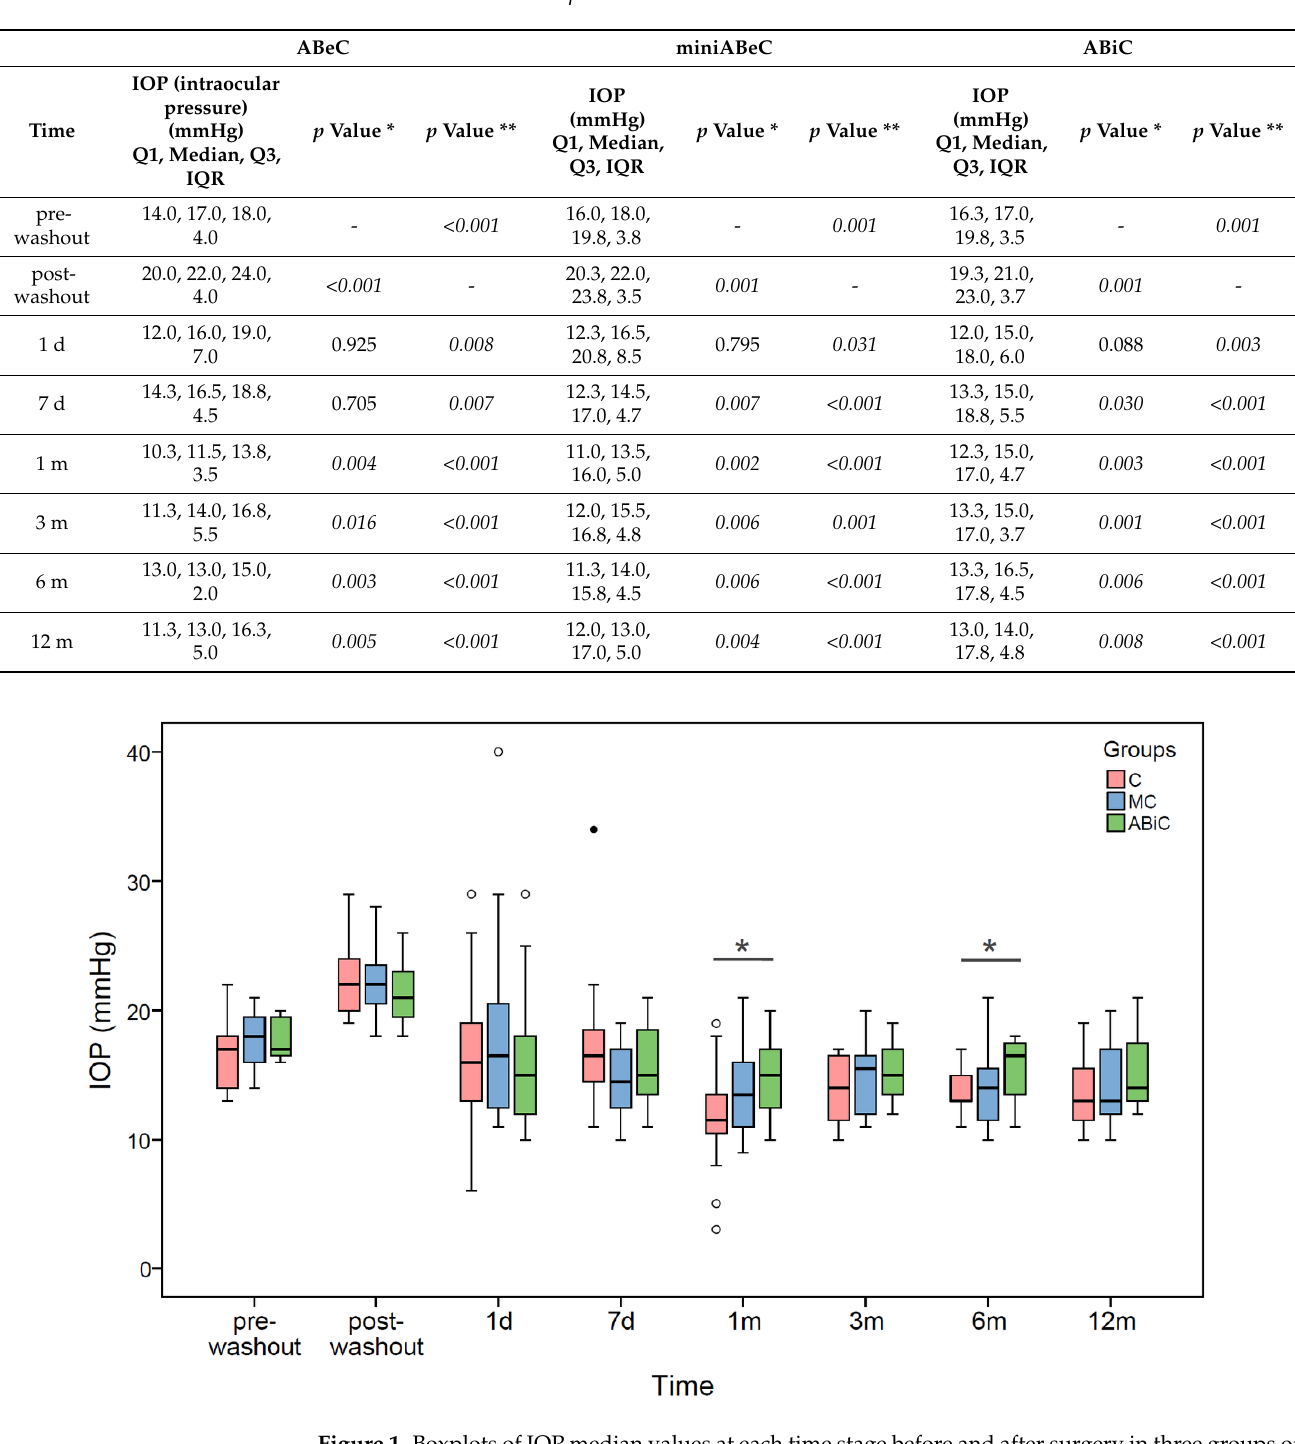
Figure 1. Boxplots of IOP median values at each time stage before and after surgery in three groups of patients: ab externo canaloplasty (ABeC), minicanaloplasty (miniABeC) and ab interno canaloplasty (ABiC). Asterisks denote statistically significant differences between particular groups ( p < 0.05).